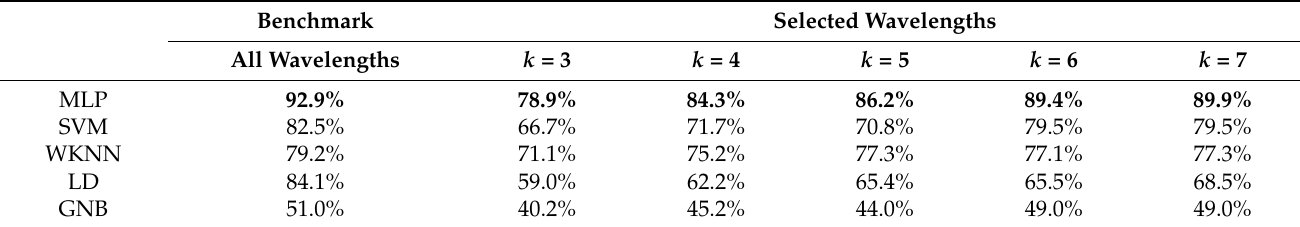
Table 4. Single-mode classification accuracies (4-fold cross-validation) for the fluorescence data.